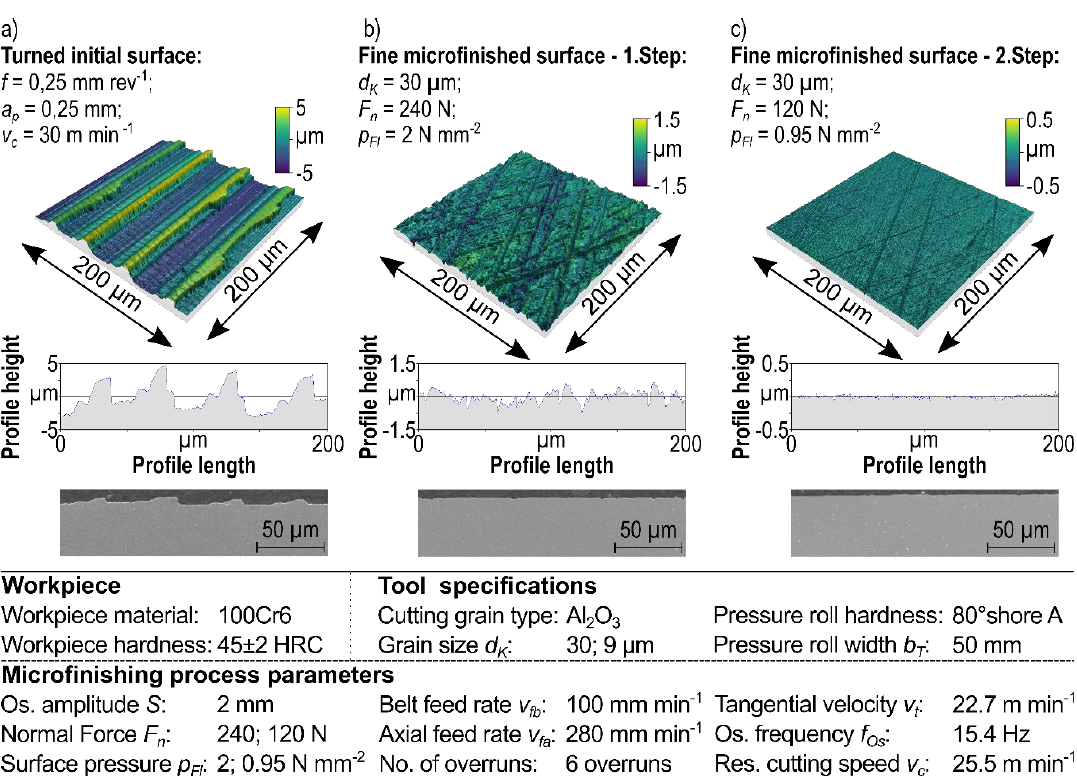
Figure 11. Topography, detailed profile, and cross section SEM picture for the machining steps ( a ) turned, ( b ) first fine microfinishing step, and ( c ) second fine microfinishing step.